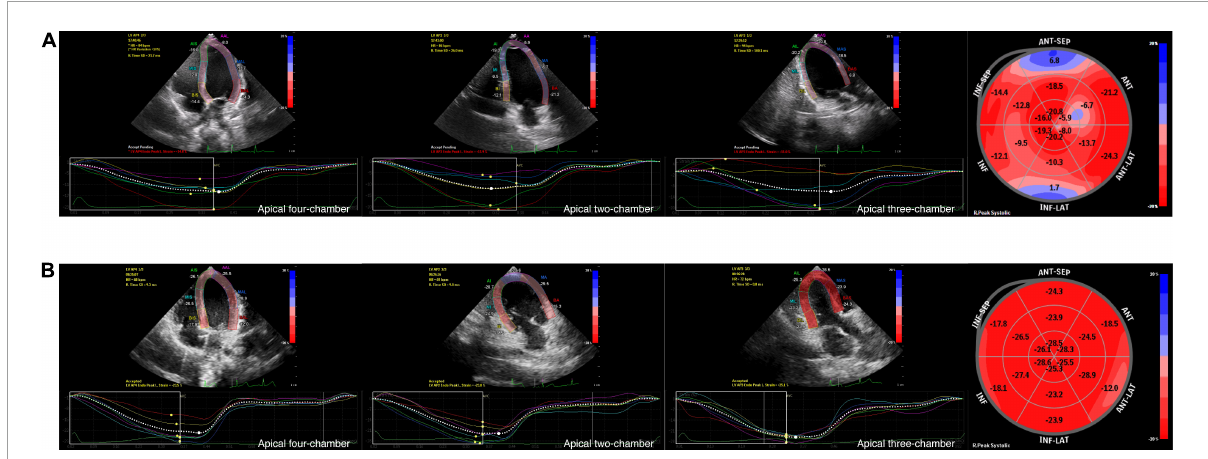
FIGURE1 Graphic example of 2D-STE analyses to derive LV longitudinal strain. Measurement of LV longitudinal strain images in AP4, AP2 and AP3 view, and segmental Bull’s eye plot (from left to right) of an 8-year-old boy with SMA (A) and an age-, gender, BSA-matched healthy control (B) by 2D-STE. Bull’s eye plot is color-coded by strain deformation, with red color regions showing longitudinal strain within normal values, pale pink color regions showing negative displacement of strain, and blue color regions showing positive displacement of strain to varying